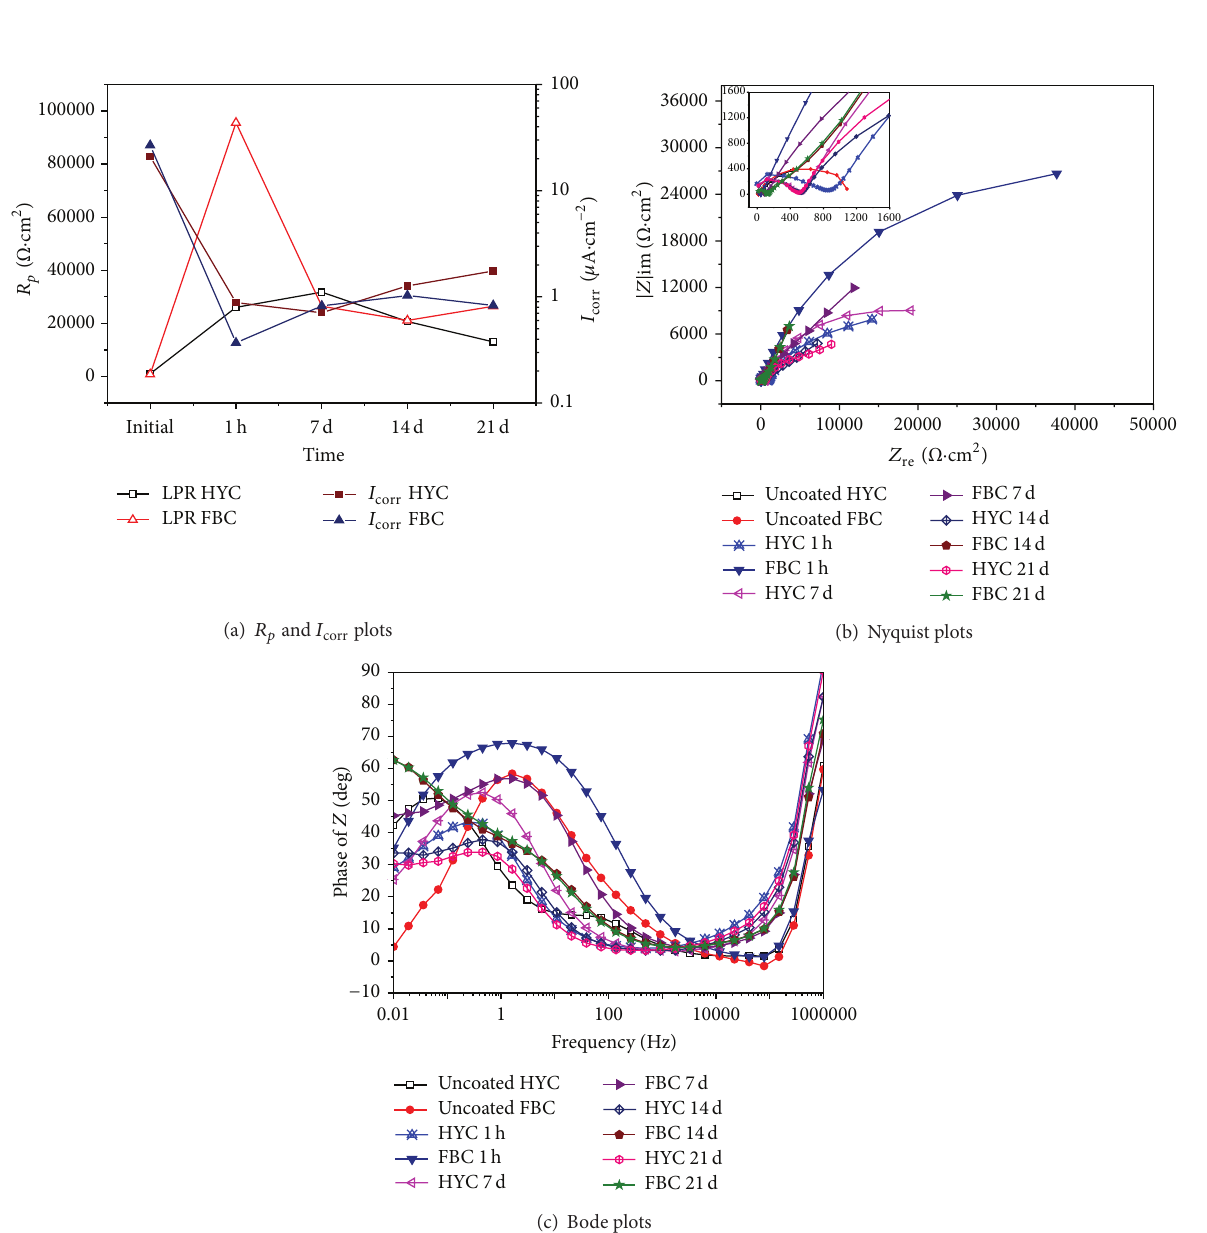
Figure 3: LPR and EIS plots of electrodes coated with HYC and FBC in chloride